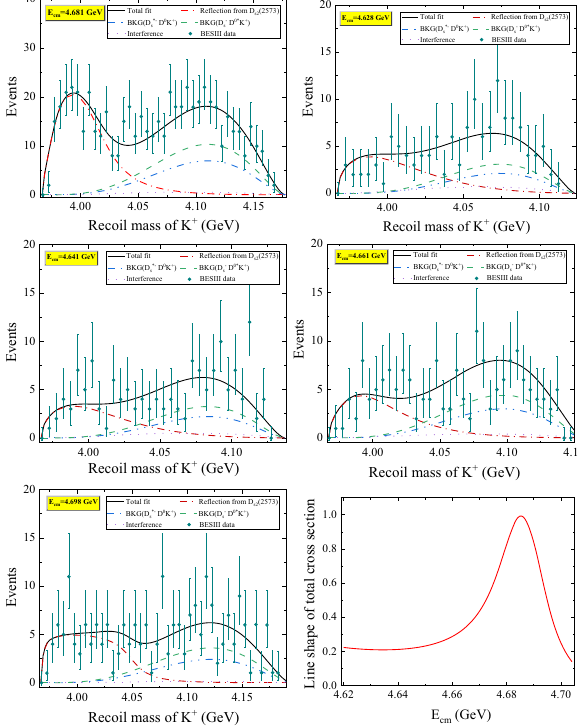
Fig. 2 The fit to the experimental data of e + e − → D − s D ∗ 0 K + or D ∗− s D 0 K + by line shapes on recoil mass spectrum of K + at five CM energy points. Additionally, the theoretical line shape of the total cross section based on above fit is also performed. Here, only the reflection ( 2573 ) and normal nonpeaking con- from charmed-strange meson D ∗ s 2 tributions are